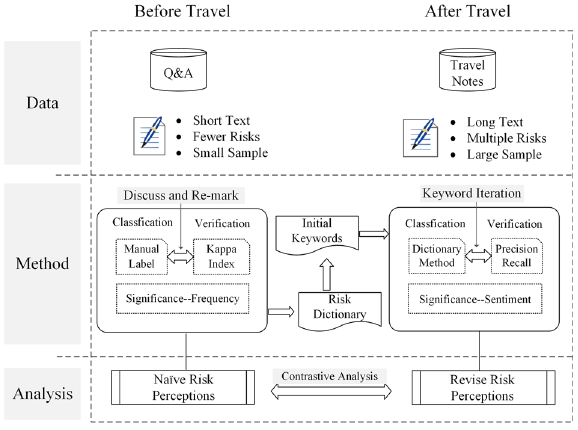
Fig. 2 Experimental framework. It demonstrates the experimental data, methods and analysis